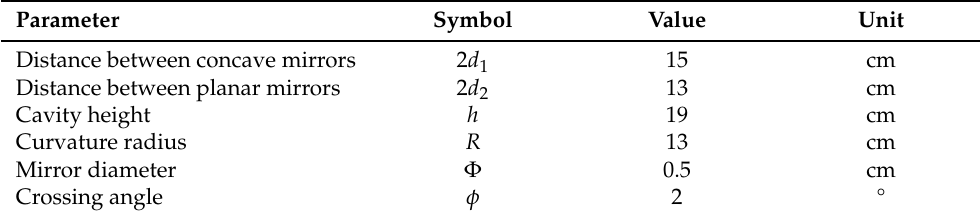
Table 4. Parameters defining the FPC cavity geometry for the XLS-based ICS